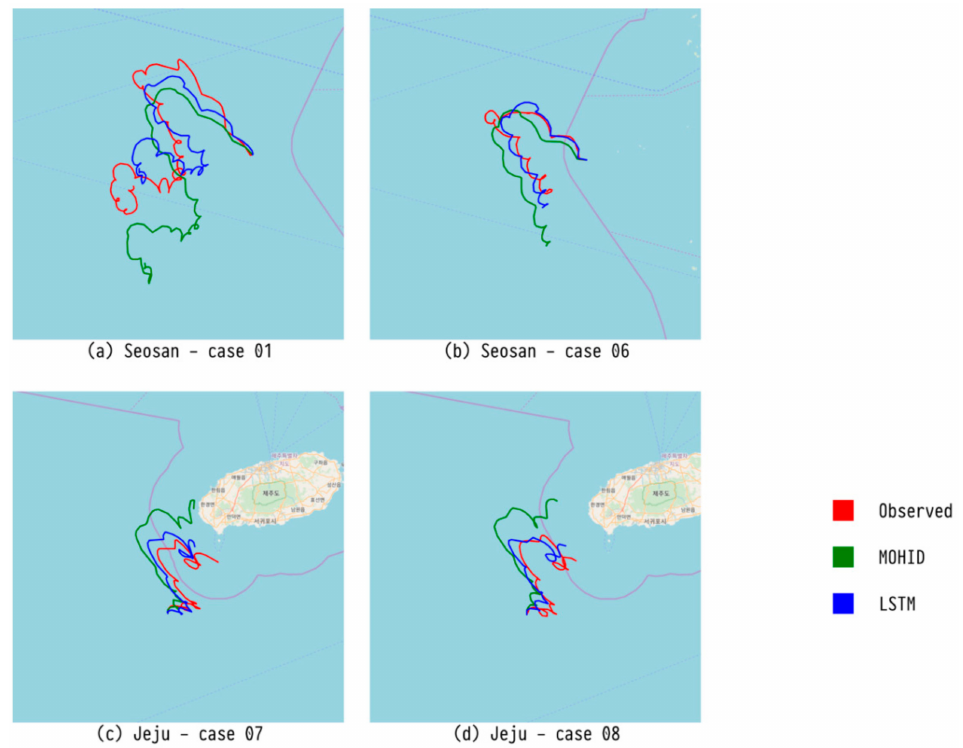
Figure 9. Comparison of trajectory predicted by our LSTM model, trajectory predicted by an existing numerical model (MOHID), and observed trajectory for four major drifters.